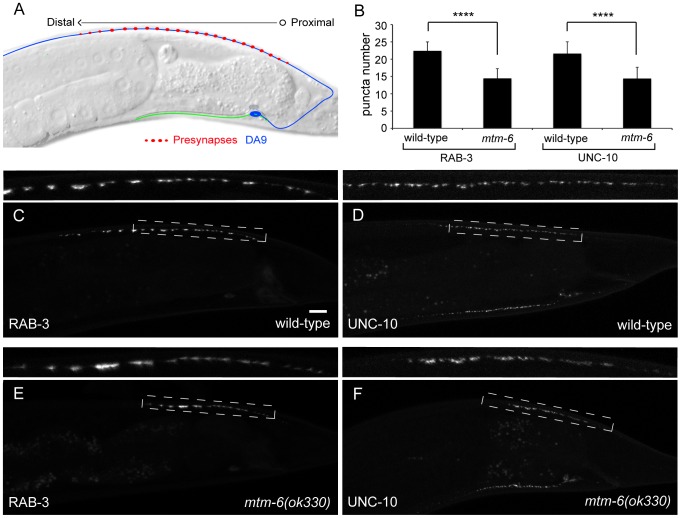
Loss of mtm-6 causes a reduction in the number of DA9 presynaptic puncta.(A) Schematic of DA9. The dendrite of DA9 extends anterior from a cell body in the ventral side of the animal. The axon of DA9 extends towards the posterior before extending a commissure to the dorsal nerve cord, where the axon turns and continues towards the anterior of the animal. Synapses form with a stereotyped number and location on to muscle and Ventral D neurons. (B) Quantification of the number of puncta formed in wild-type and mtm-6 (ok330) animals using GFP::RAB-3 to mark presynapses and UNC-10::GFP as a marker for active zones (n>60, **** is p<0.0001). (C-F) mtm-6 (ok330) animals show a reduced number of dorsal synaptic puncta when compared to wild-type animals for the GFP::RAB-3 and UNC-10::GFP markers. (C) Wild-type; GFP::RAB-3. (D) Wild-type; UNC-10::GFP. (E) mtm-6(ok330); GFP::RAB-3. (F) mtm-6(ok330); UNC-10::GFP. The UNC-10::GFP puncta on the ventral side of the animal correspond to the VA12 motor neuron. The dashed boxes mark the regions that are enlarged for the insets above each window. Error bars are SD. Scale bar is 10 µm.